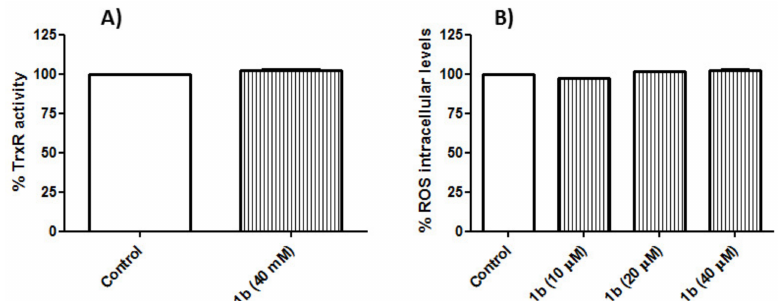
Figure 5. ( A ) Analysis of recombinant TrxR activity upon incubation with 40 µ M of complex of [Au(L2b)(IMe)] ( 1b ). ( B ) Measurement of ROS intracellular levels on Caco-2 cells upon 1 h incubation with 10, 20 or 40 µ M of complex of [Au(L2b)(IMe)] ( 1b